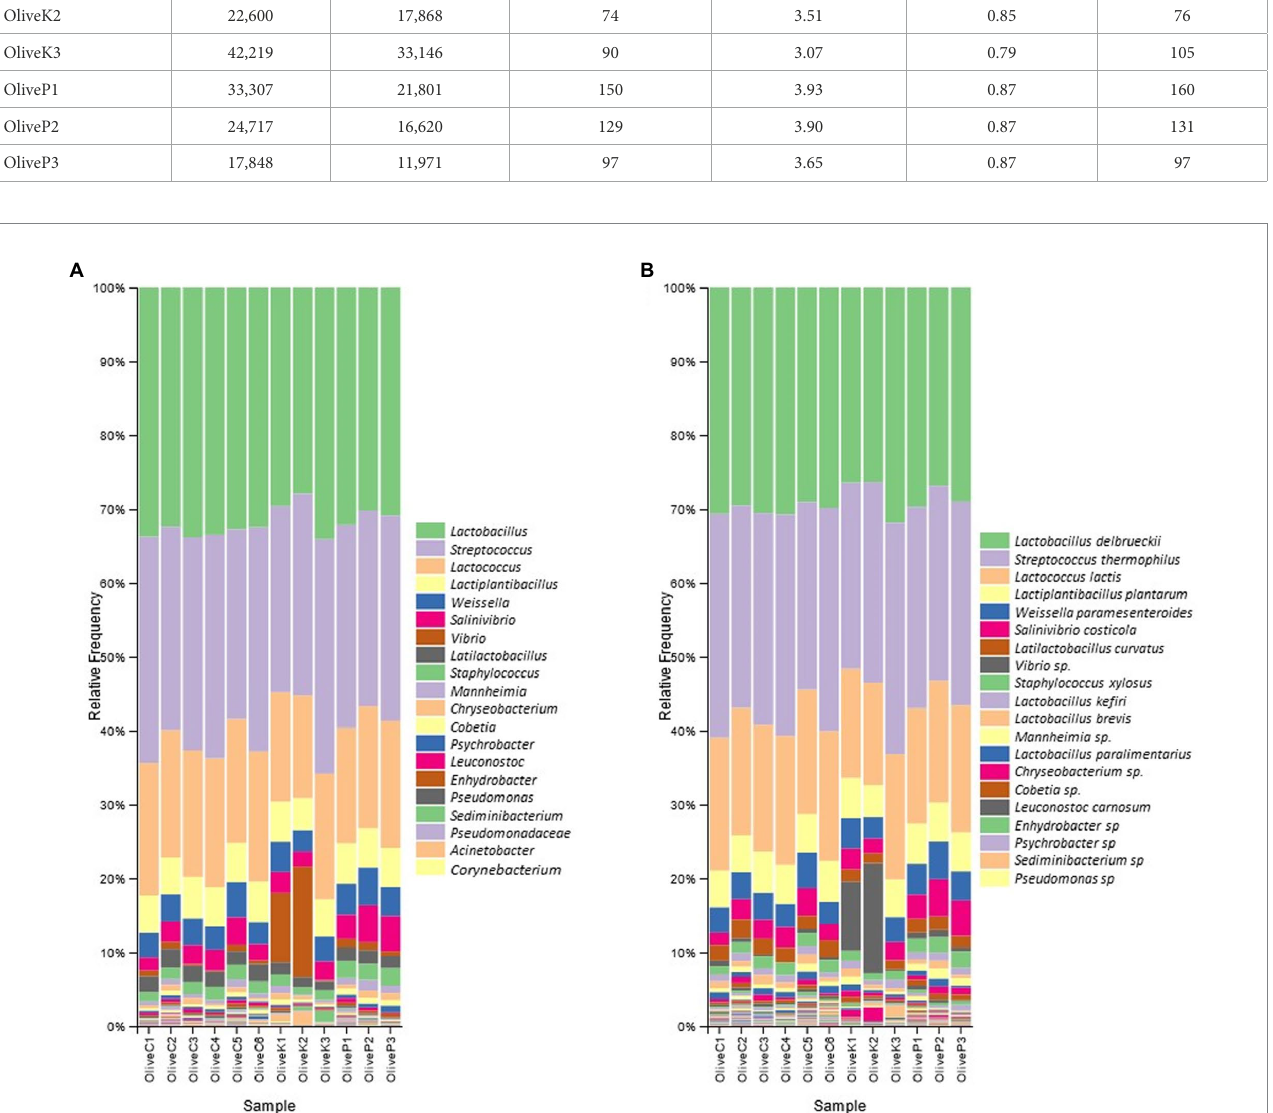
FIGURE 1 Relative abundance (%) of bacterial communities of fermented olives, Cypriot (C), Kalamata (K) and Picual (P), from different regions, as revealed by 16S rRNA high throughput sequencing. (A) in genus level; and (B) in species